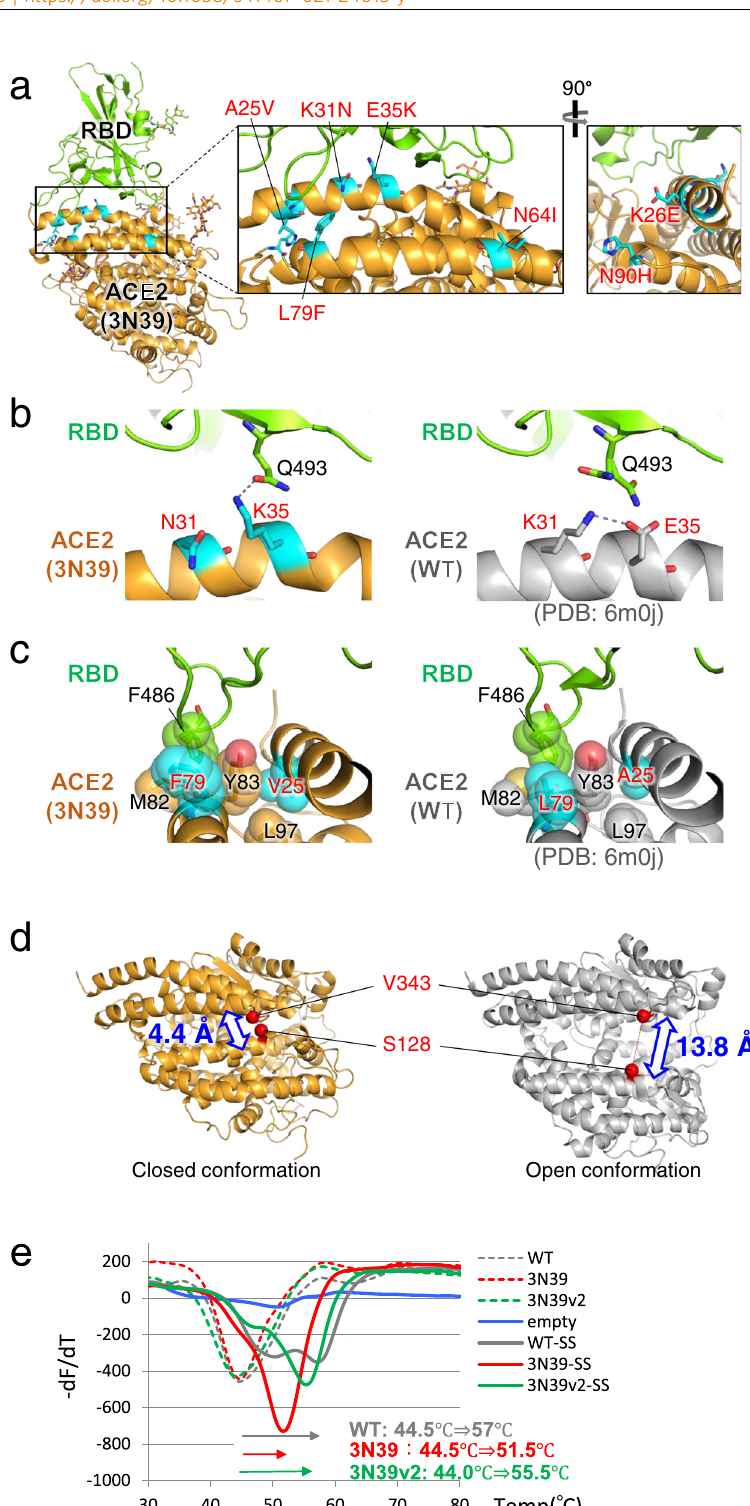
Fig. 2 Structural analysis of 3N39 mutant in complex with RBD. a Overall structure. 3N39 ACE2 and RBD are shown in orange and green, respectively. The mutated residues in 3N39 are shown as cyan stick models. The expanded views of the PD1 region are provided in the inset. b Structural comparison of the K31N/ E35K mutation site in 3N39 (left panel) with its corresponding site in WT (right panel). Hydrogen-bonding interactions (within 3.0Å) are indicated by dashed lines. c Structural comparison of the L79F/A25V mutation site in 3N39 (left panel) with its corresponding site in WT (right panel). F486 residue of RBD and hydrophobic residues composing the F486 binding pocket of ACE2 are shown as stick models with transparent sphere models. d Comparison of the distances between C β atoms of S128 and V343 residues in the closed and open conformations. e Stabilizing effect of S138C/V343C mutation. Various versions of ACE2-His proteins, with (solid lines) or without (dotted lines) the S138C/V343C disul fi de mutation (SS), were subjected to the differential scanning fl uorimetry using SYPRO ™ Orange as the probe dye. The Tm value for each mutant is estimated by the peak temperature of the -dF/dT plot, and the Tm shift caused by the SS mutation is shown at the bottom. The experiments were independently performed three times and similar results were obtained. One representative data were